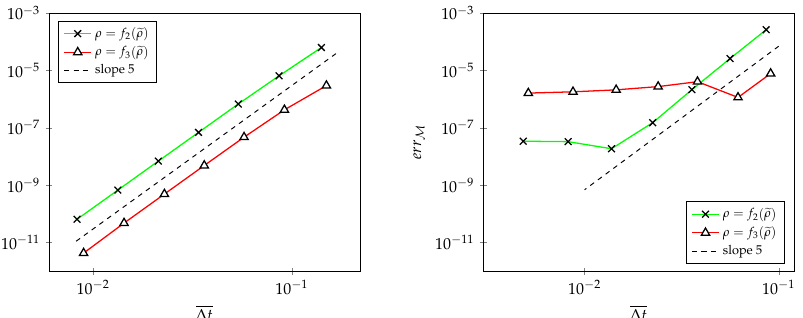
Figure 5. Square density wave advection—mass conservation analysis for each choice of the change of density variable at density ratio r ρ = 2 ( left ) and r ρ = 800 ( right ) using the implicit ESDIRK5(8) scheme and an increased number of Gauss quadrature rule points. DG polynomial approximation of degree k = 6 on a uniform mesh of 10 × 1 square elements.